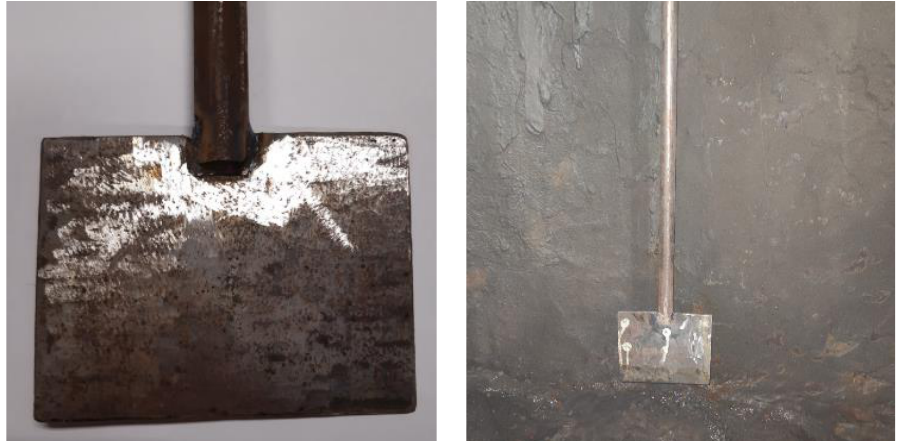
Figure 14. View of the reference plate installed inside the classifier tank.